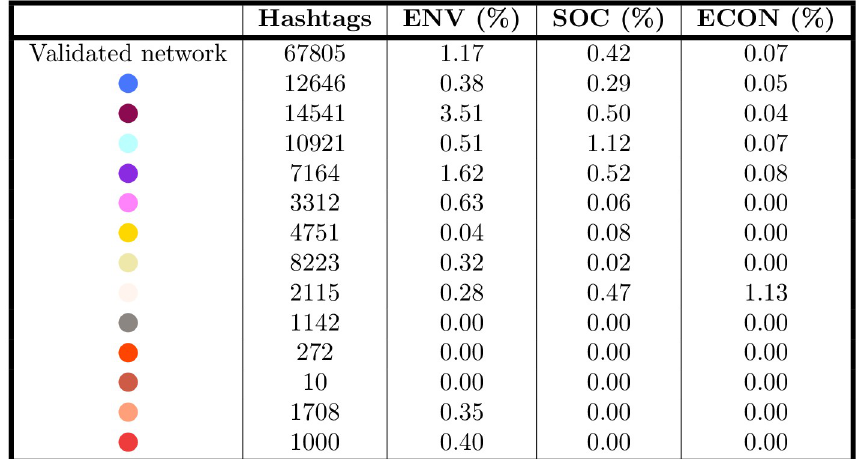
Fig 10. Frequency of hashtags in the validated network, by community and CSR dimension. As expected by analysing the community composition in terms of ATECO code, the attention on the various group is quite different: for instance, the ℌ Environmental Sustainability H community (in purple) has a frequency of hashtags in the Environmental dimension that is greater than twice the value observed on the entire validated network. Similar considerations apply to the ℌ Remote Working H community (in sky blue) for the social dimension and the ℌ Mobility H one (in white) for the social one.